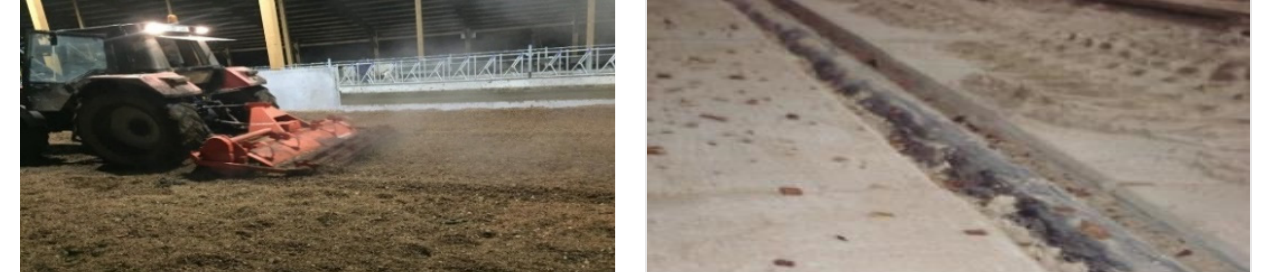
Figure 3. Illustration of the stimulation of the composting process by mechanically aerating with oxygen into the pack ( left ) and the use of pipes in the concrete floor for suckling or pushing air in the bedded-pack ( right ). Source: Authors.